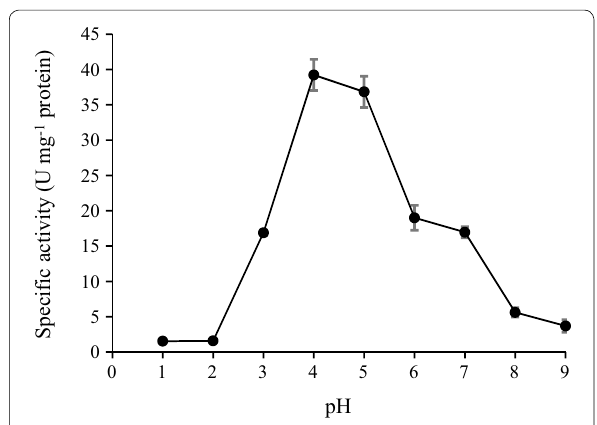
Fig. 5 Effect of pH on Leohumocola incrustata specific activity. The enzyme was incubated at 45 °C for 1 h. All error bars are represented as the standard errors of the means (SEM)